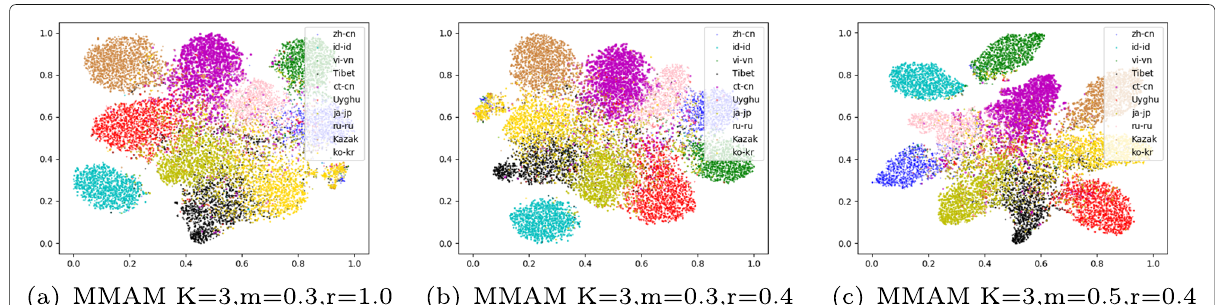
Fig. 9 Language embeddings of our proposed method are plotted by t-SNE, under test-1s on AP17-OLR. Each shape/color represents a different language. a EER=8.42, C